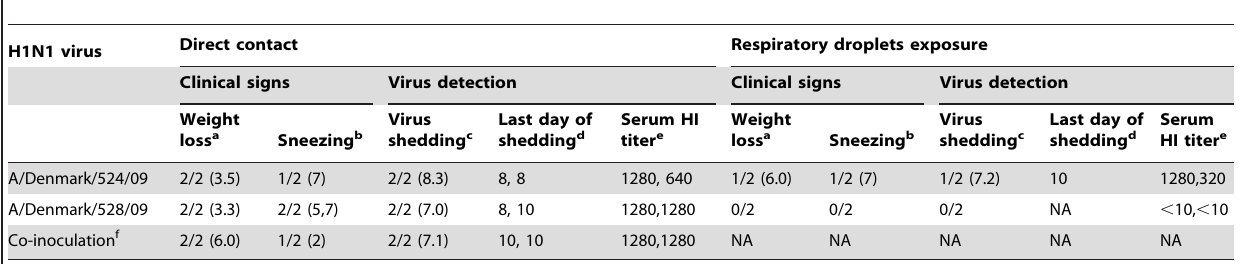
Table 3. Clinical signs, virus replication, and seroconversion in contact ferrets.